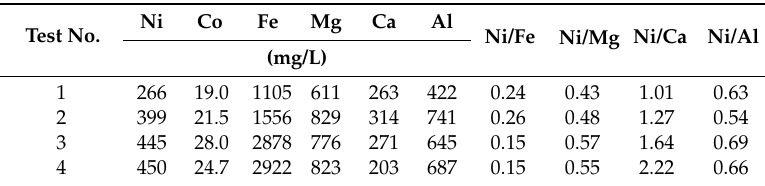
Table 3. Comparison of pregnant leach solution (PLS) quality and selectivity of each leaching medium. Test No.